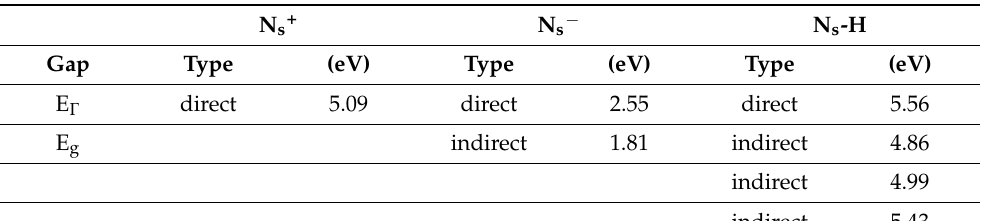
Table 4. B3LYP/6-21G band gaps in N s+ , N s − and N s -H taken from Figure 2b–d where the spin- allowed and spin-forbidden transitions have identical